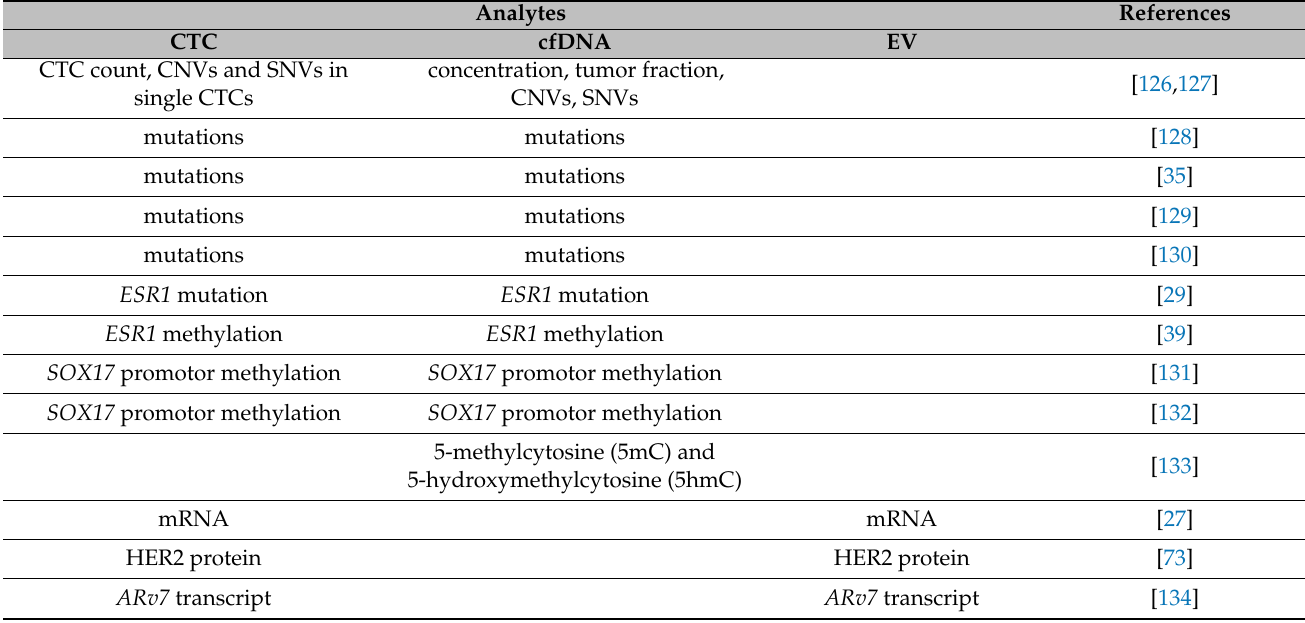
Table 1. Molecular characterization of two liquid biopsy analytes from studies describing their direct comparison in matched samples. Abbreviations: ARv7 : androgen receptor variant seven tran- script; cfDNA: cell-free DNA; CNVs: copy number variations; CTC: circulating tumor cell; ESR1 : gene encoding for the estrogen receptor protein; EV: extracellular vesicle; HER2: receptor tyrosine-protein kinase erb-b2; mRNA: messenger RNA; SNVs: single-nucleotide variants; SOX17 : SRY-box transcrip- tion factor